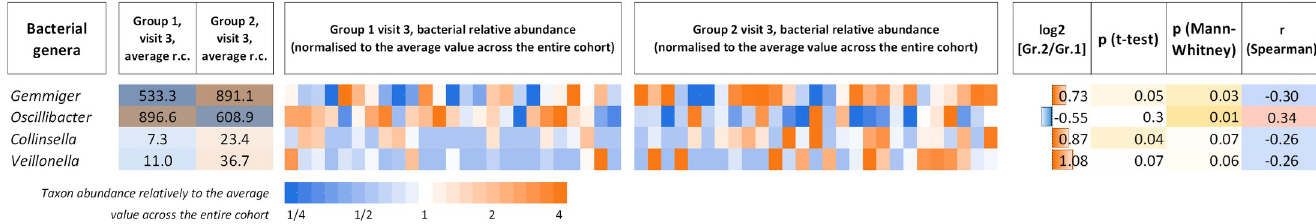
Fig 5. Statistically significant differences in the composition of intestinal microbiota genera between groups 1 and 2 at visit 3. Columns 2 and 3 present the relative content (r.c.) of bacterial genera averaged over all samples in each group. The heatmaps in columns 4 and 5 show the bacterial content profiles for individual